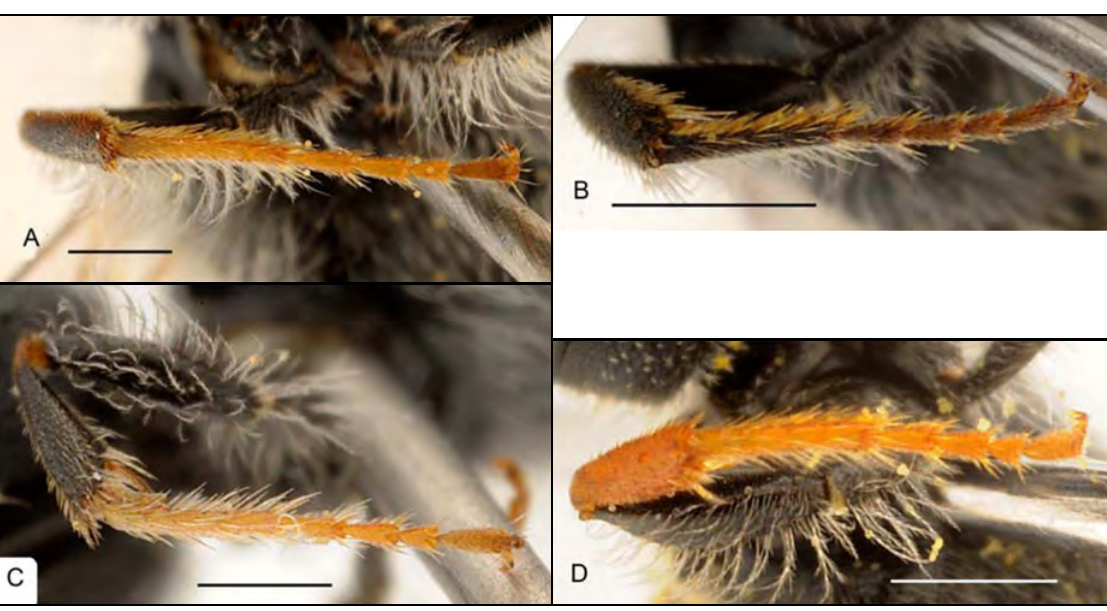
Fig. 12. Lateral habitus, ♂. — A . Lasioglossum ( Capalictus ) mosselinum (Cockerell, 1945). — B . Lasioglossum ( Capalictus ) timmermanni sp. nov. — C . Lasioglossum ( Capalictus ) hantamens e sp. nov.. — D . Lasioglossum ( Capalictus ) tigrinum sp. nov . Scale line = 1 mm.